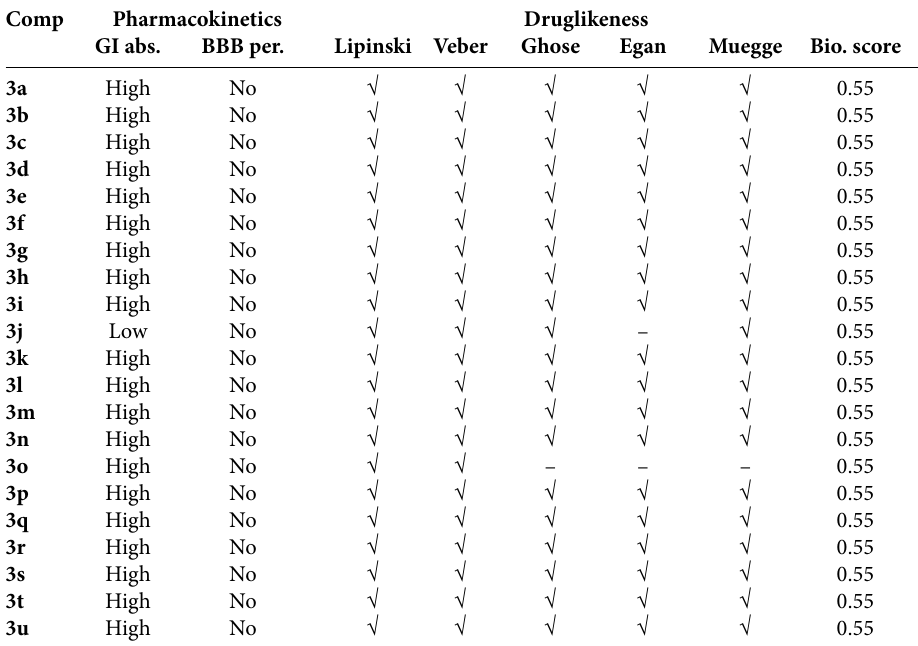
Table 3 . The drug-likeness and pharmacokinetic properties of target compounds ( 3a - u ). Comp Pharmacokinetics